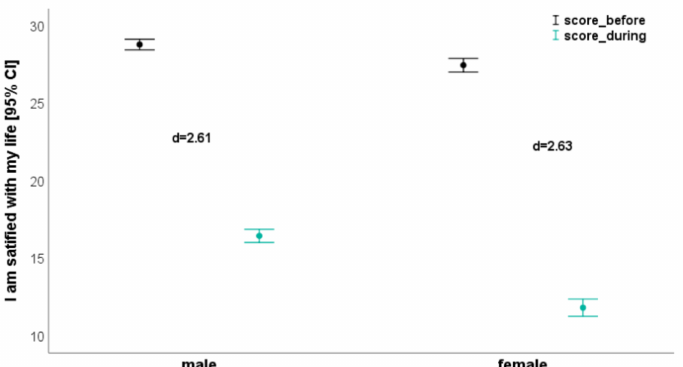
Figure 1. I am satisfied with my life—depending on gender before and during